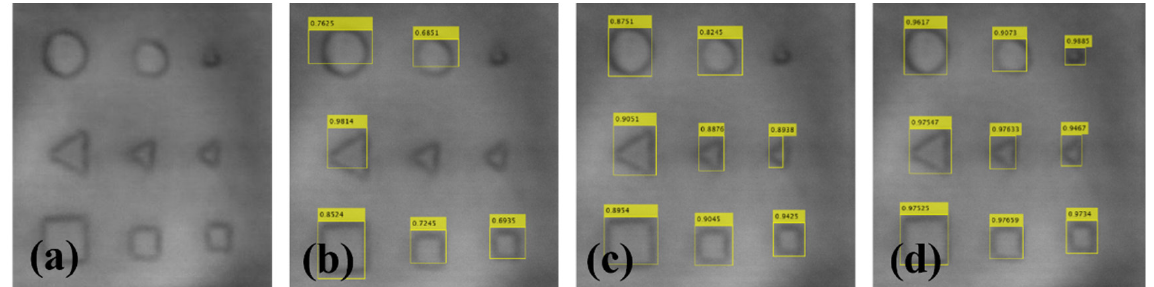
Figure 11. Comparison of defect detection performance of the validation set: ( a ) original, ( b ) fast R-CNN, ( c ) faster R-CNN, and ( d ) improved faster R-CNN.